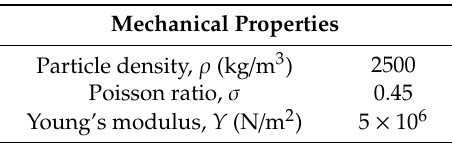
Table 1. Mechanical properties of particles.